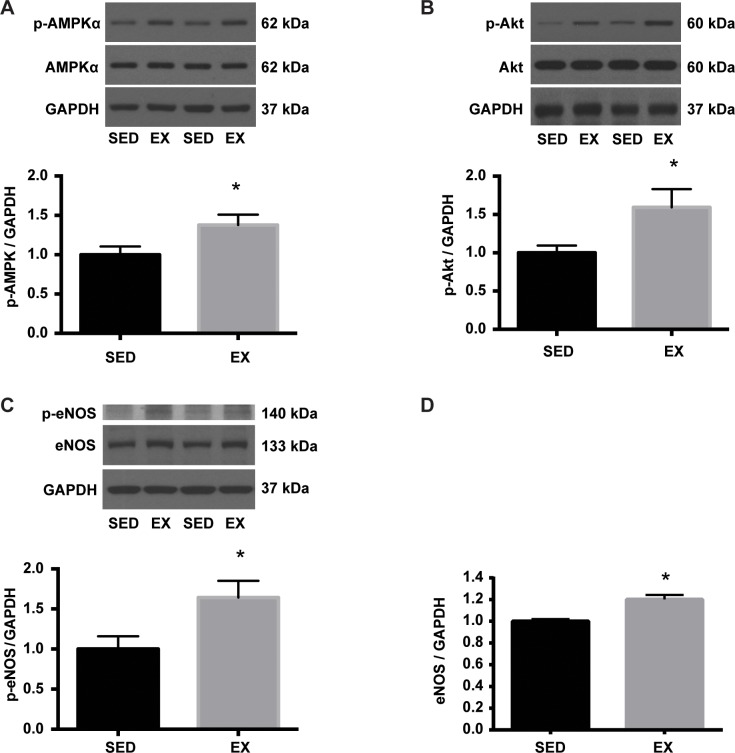
Increased p-AMPK, p-Akt, and p-eNOS in the aorta of EX mice.Equal amounts of aortic homogenate were separated by SDS-PAGE. Representative blots are shown above each summary graph. A. Phospho-AMPKα (Thr172) was normalized to GAPDH expression and expressed relative to SED mean (n = 7 per group). *p<0.05. B. Phospho-Akt (Ser473) was normalized to GAPDH expression and expressed relative to SED mean (n = 7 per group). *p<0.05. C. Phospho-eNOS (Ser1177) was normalized to GAPDH expression and expressed relative to SED mean (n = 7 per group). *p<0.01. D. Total eNOS protein expression was normalized to GAPDH and expressed relative to SED mean (n = 7 per group). *p<0.001.